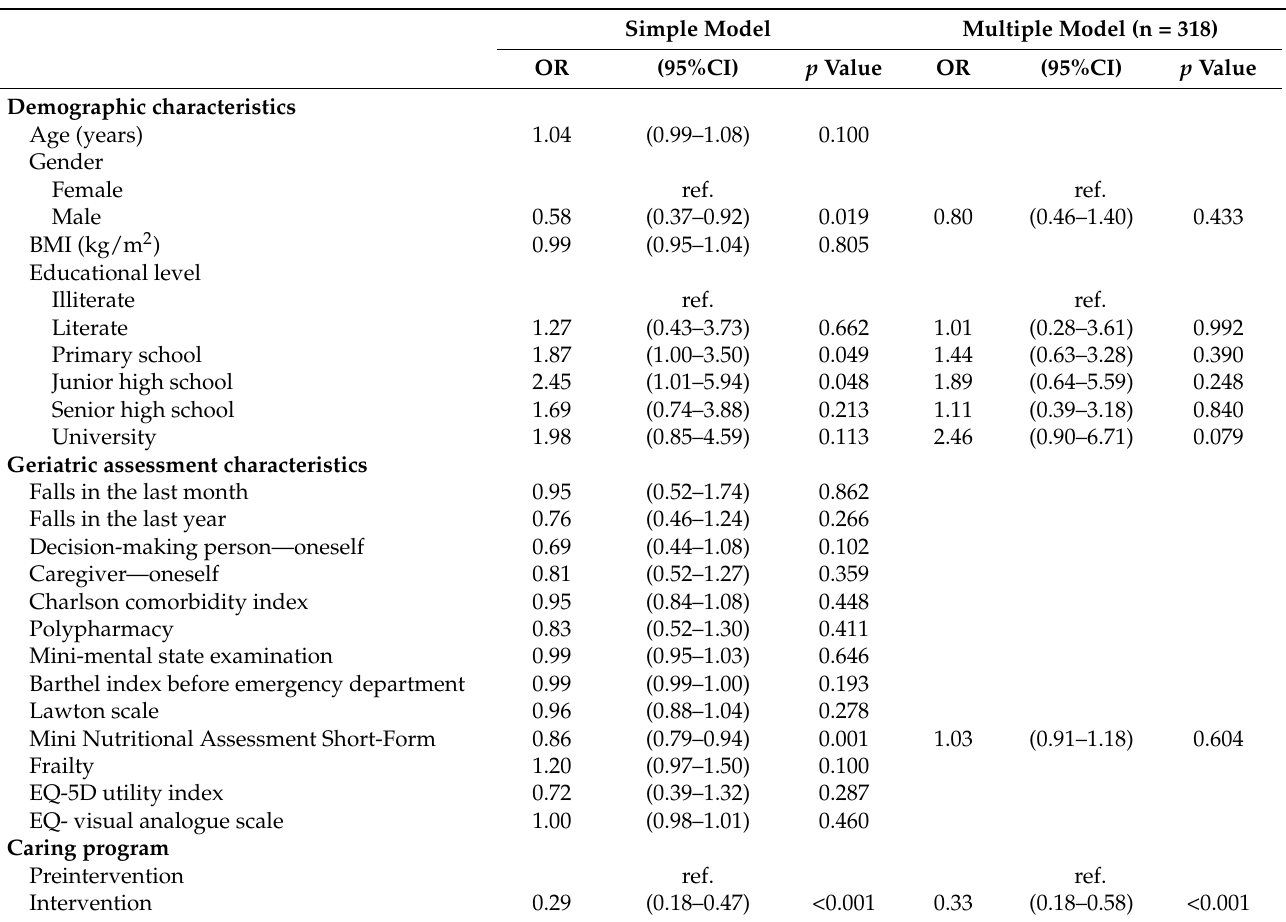
Table 3. Predictors of admission at the index emergency department